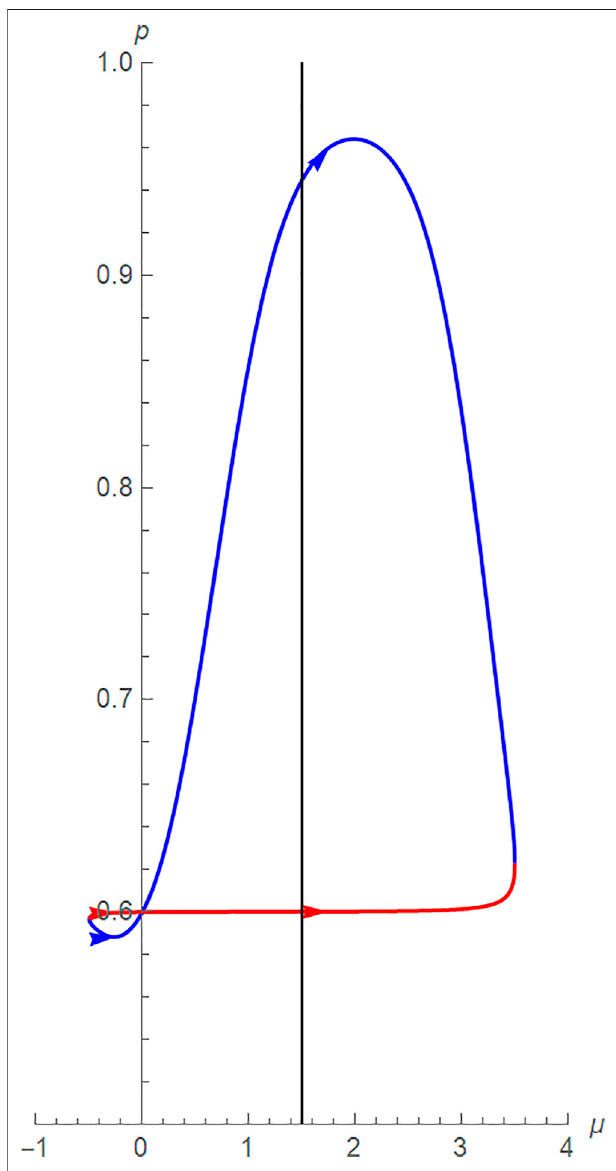
FIGURE 8 | P .6 ( z (cid:2) 1 ) of points distance 2 from ( μ , σ ) = (1.5, 6) as μ increases (indicated by the arrow ’ s direction) from − 0.5 to